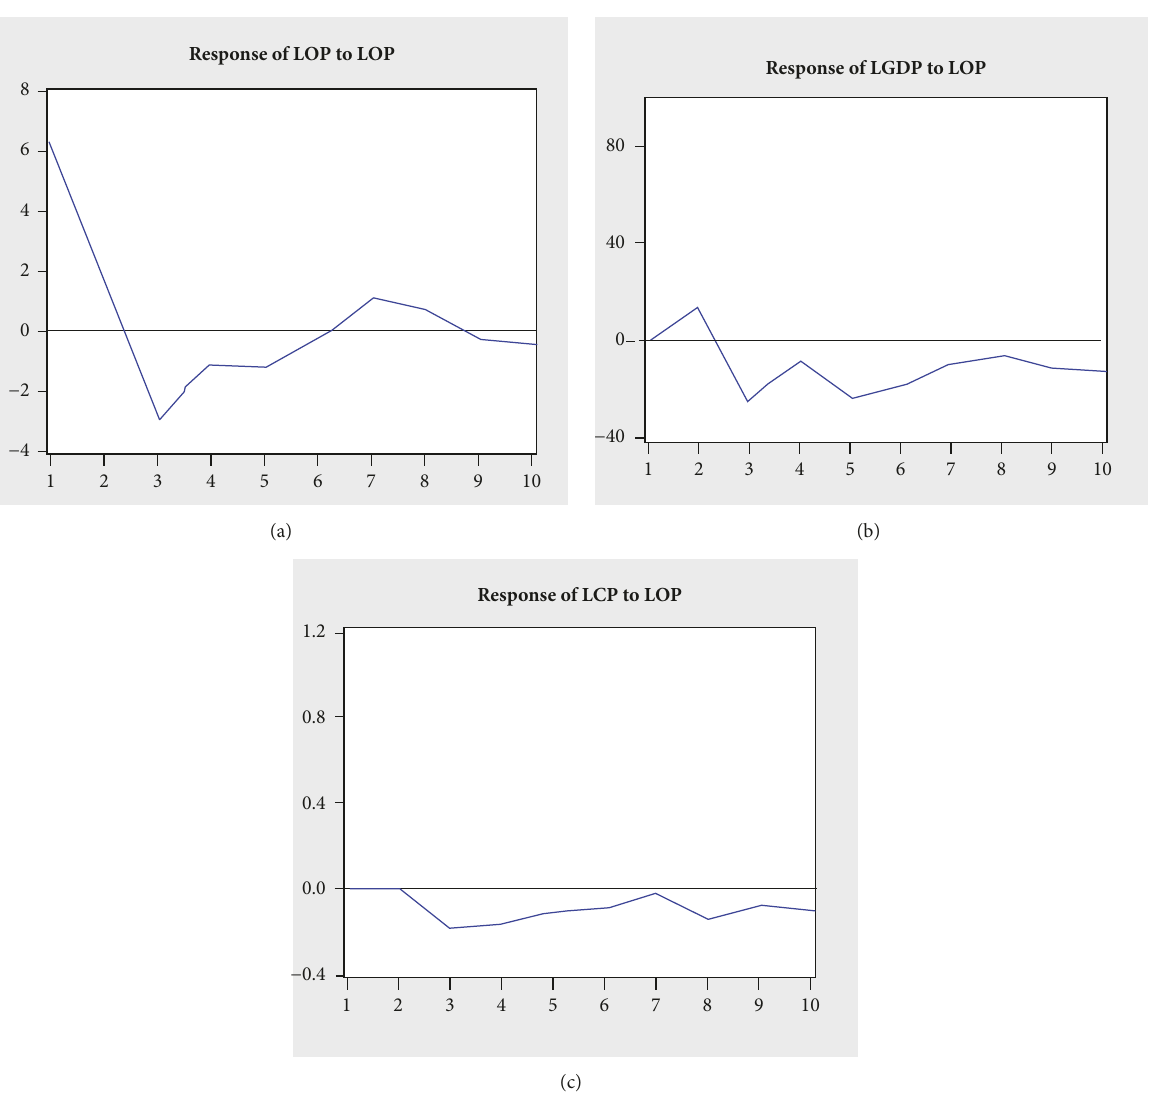
Figure 5: Impulse